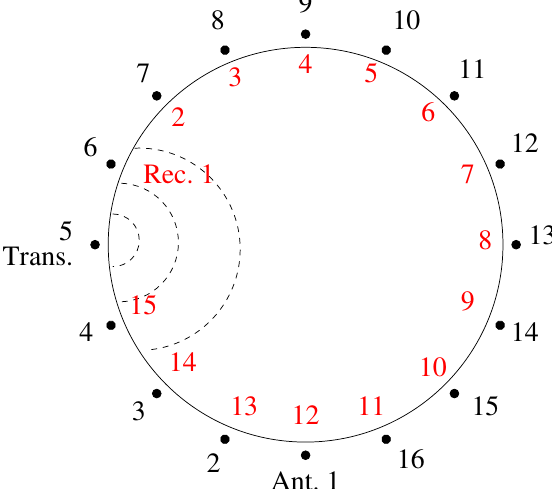
Figure 5. Schematic representation of the of the antenna numbering. The outer circle denotes the global node numbers (in black) used for the antennas when transmitting. The inner circle denotes the local node numbers (in red) used for the antennas when receiving, counting from the transmitter. In this example, Antenna 5 is transmitting.